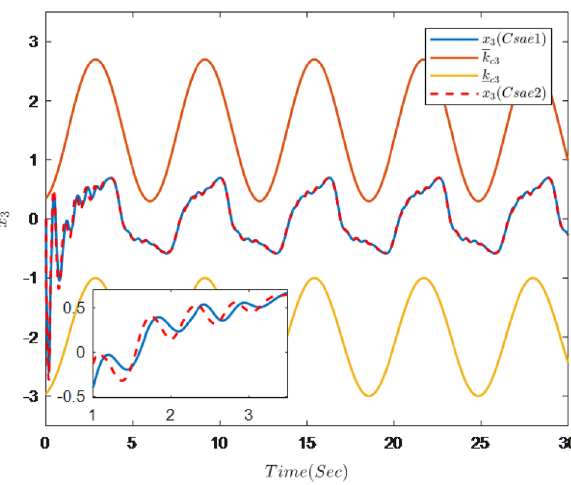
Figure 3. Trajectories of state x 3 and constraint interval.